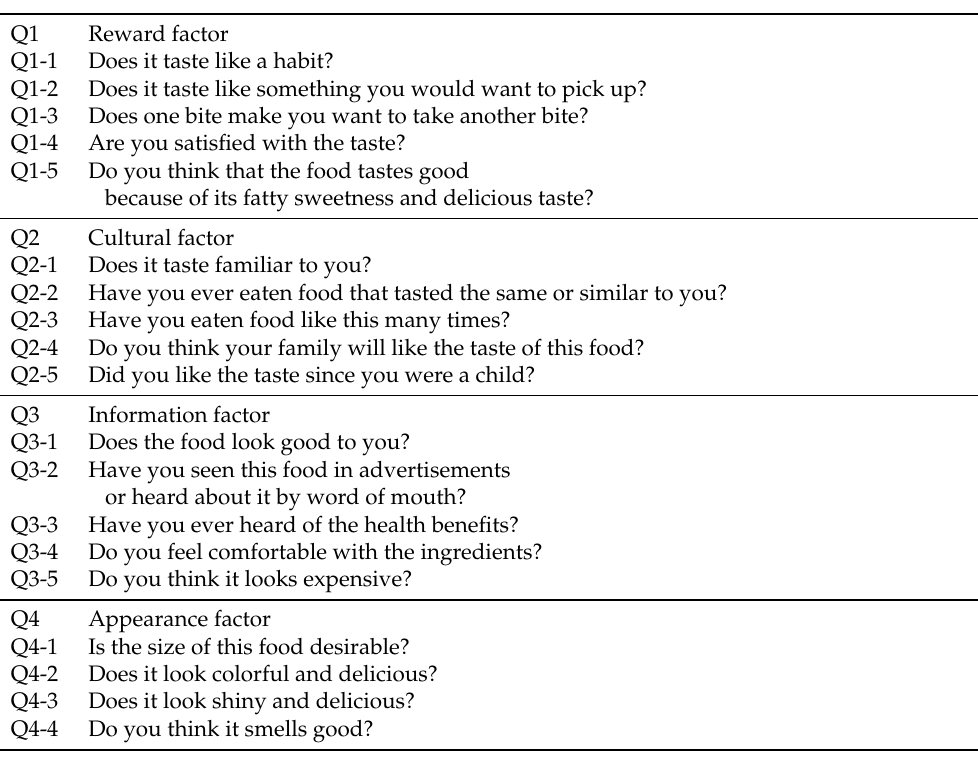
Table 2. The 19 questionnaires for the 4